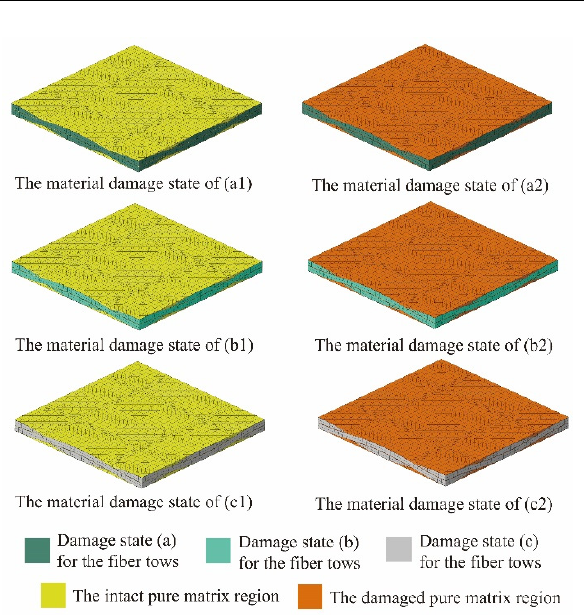
Figure 23. The meso-scale FE model of the T300/Epoxy PWF composite with different damage states of the fiber tows and the matrix.